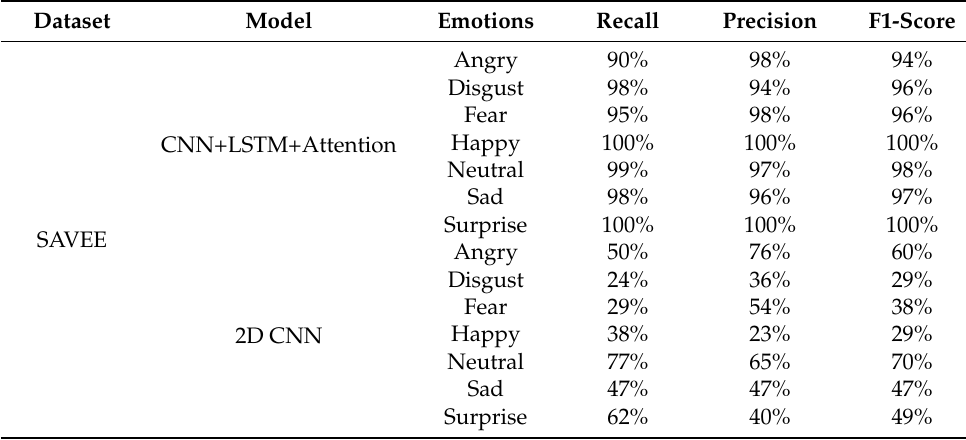
Table 4. Individual class performance evaluation metrics—SAVEE.